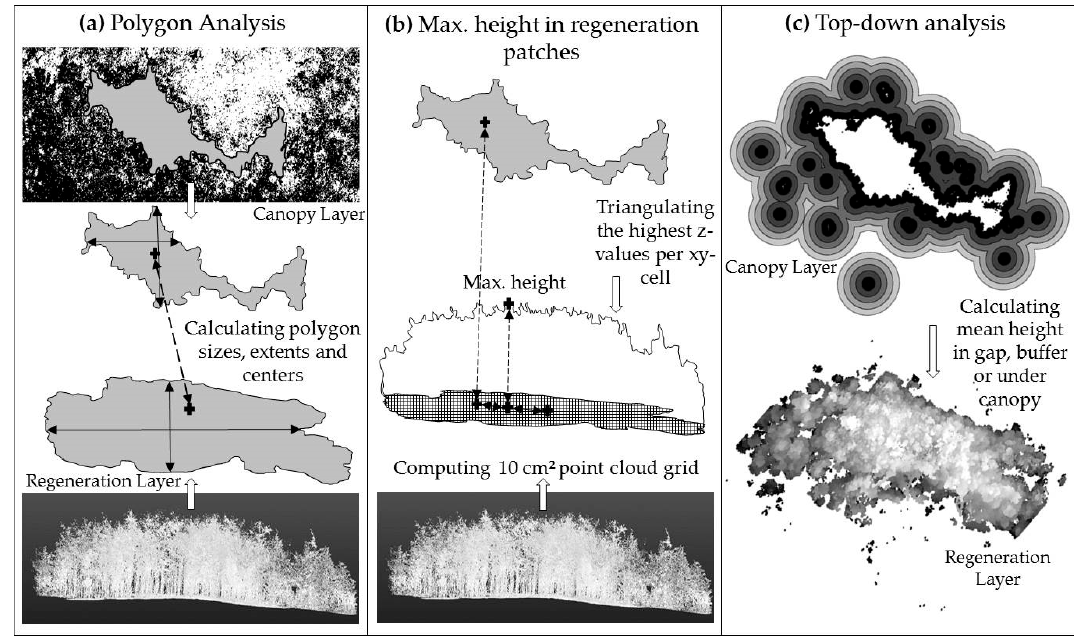
Figure 2. Illustration of the three different approaches used in this study. ( a ) Data analysis to calculate polygon sizes, maximum extents and center positions based on manually delineated polygons. ( b ) Computing 10 cm point cloud grids to identify the maximum height within the regeneration patches. ( c ) Top-down analysis based on raster data of 10 cm 2 resolution to analyze the top-down dependency.